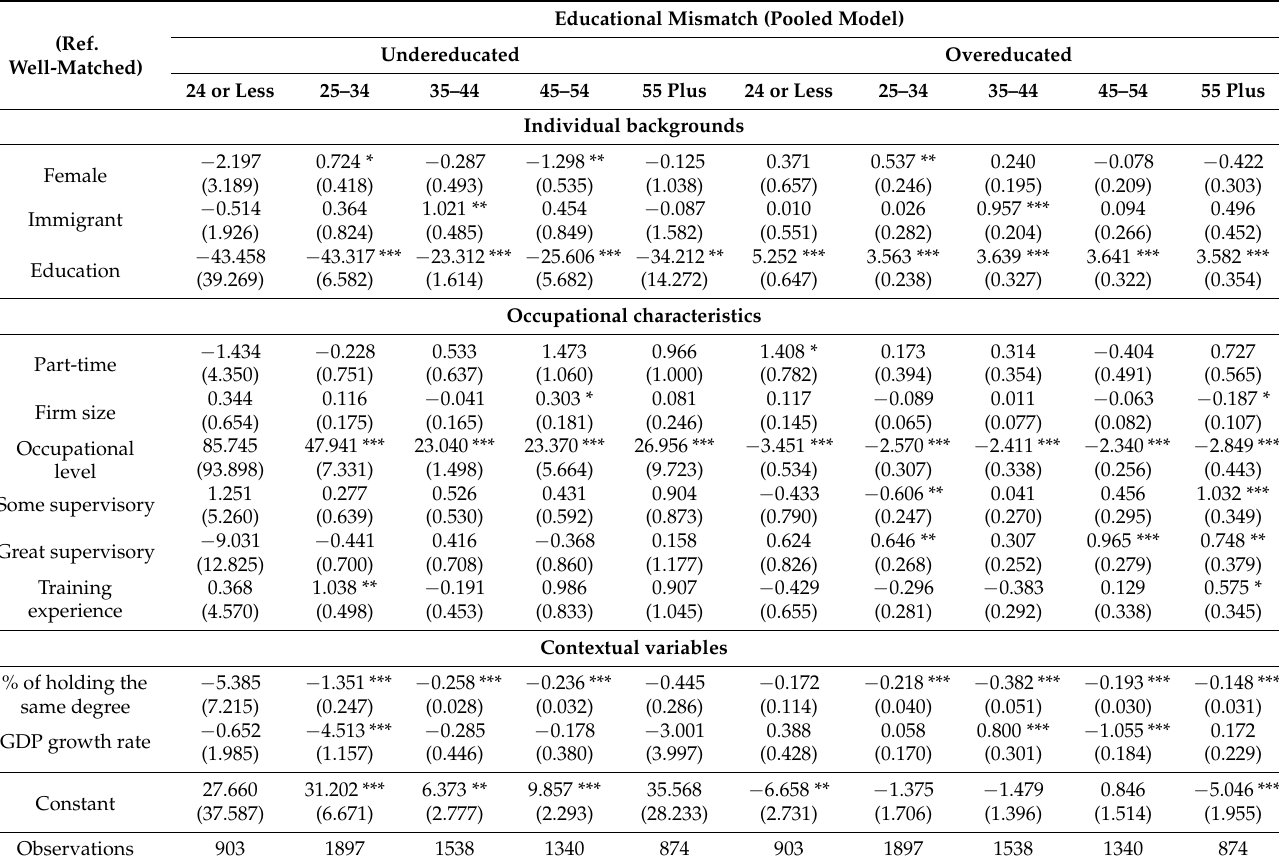
Table 10. Pooled model by age (educational